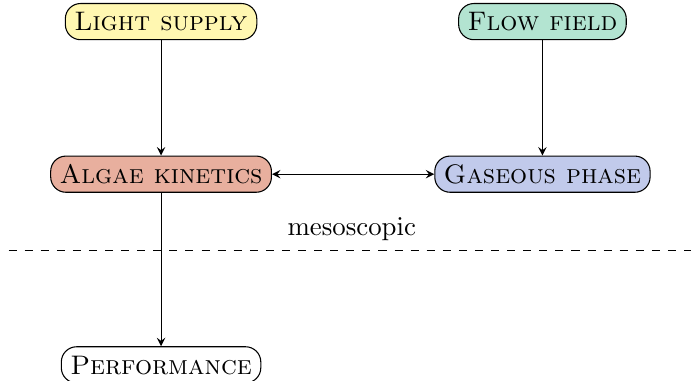
Figure 1. Interconnect model of the flow field, light supply, and mass